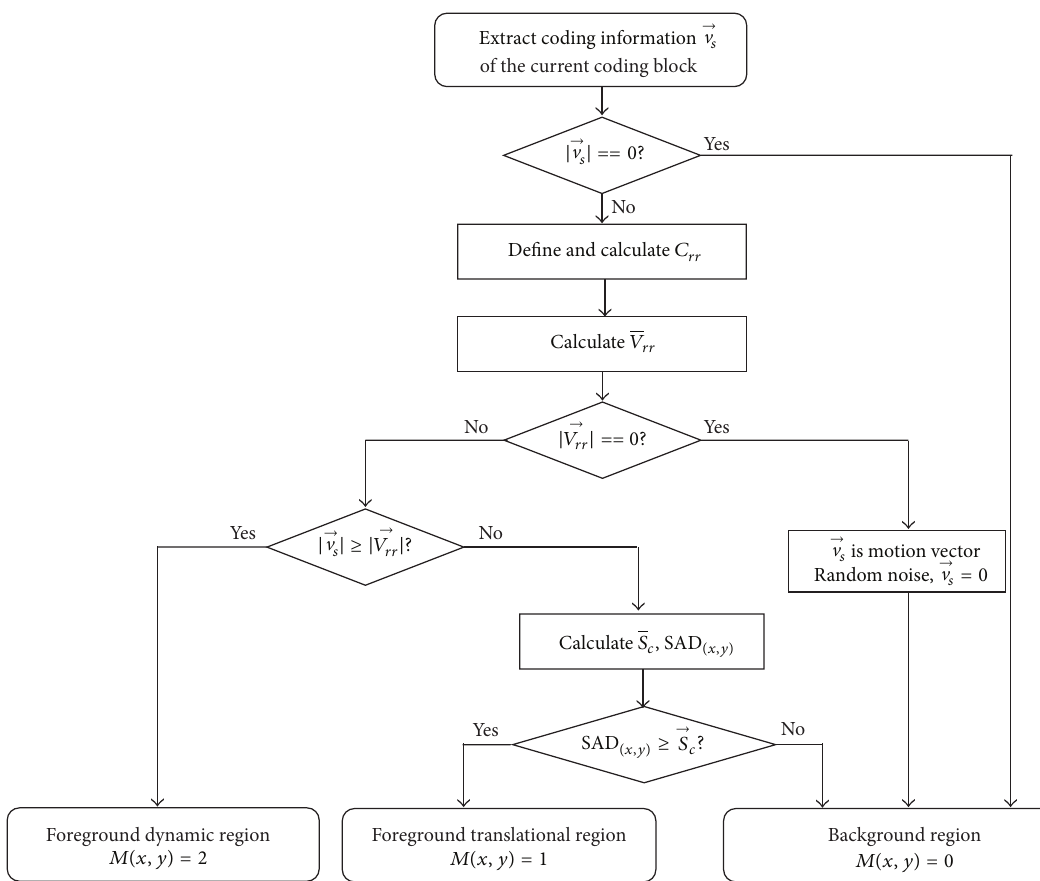
Figure 2: Flowchart of temporal visual saliency region